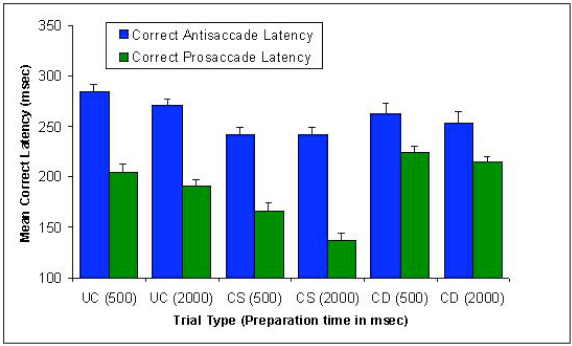
Figure 2. Pro/antisaccade average correct latencies across different trial